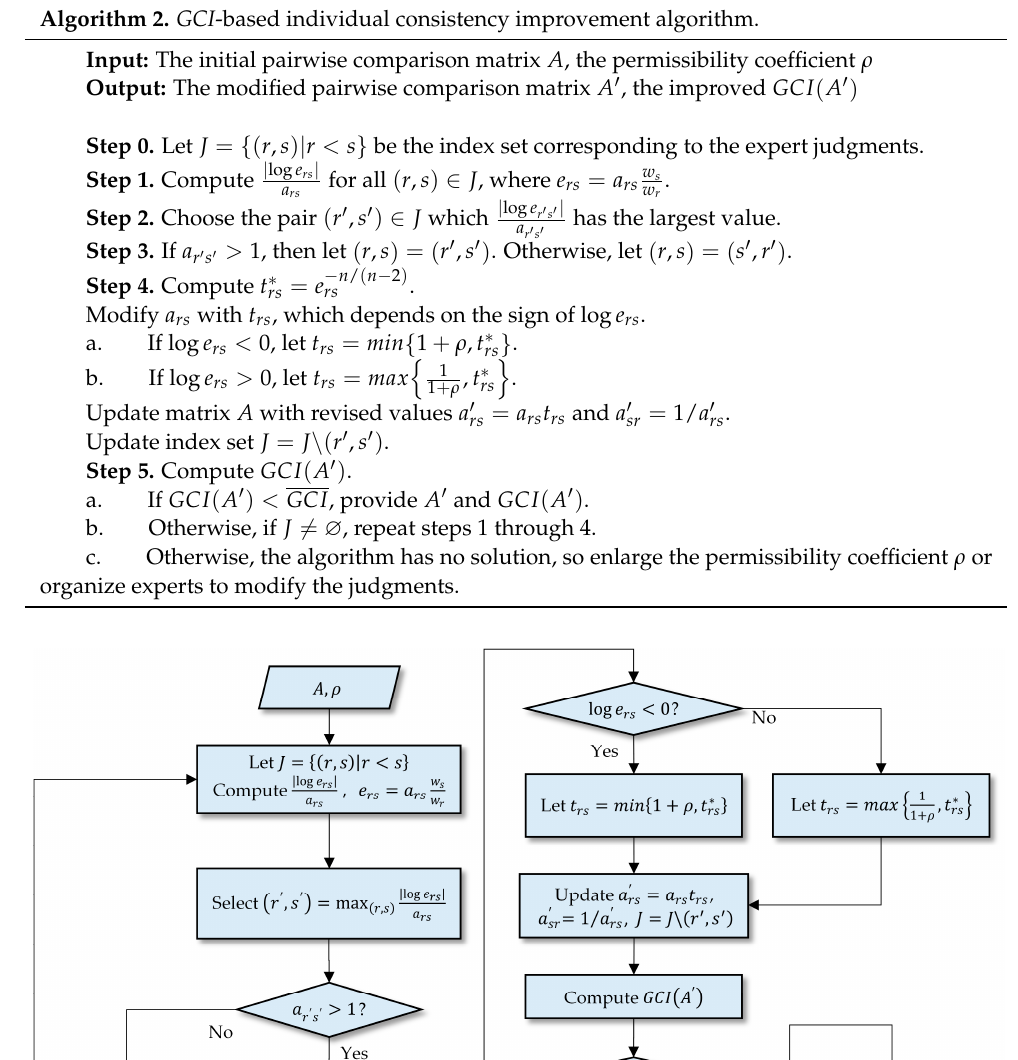
Algorithm 2 GCI -based individual consistency improvement algorithm